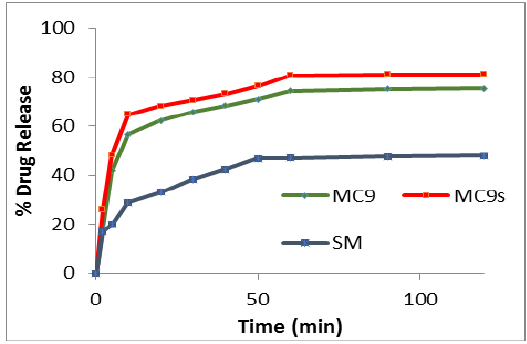
Figure (4) Dissolution profile of microcrystals MC9,MC9s and untreated powder of drug in HCl pH 1.2 at 37°C